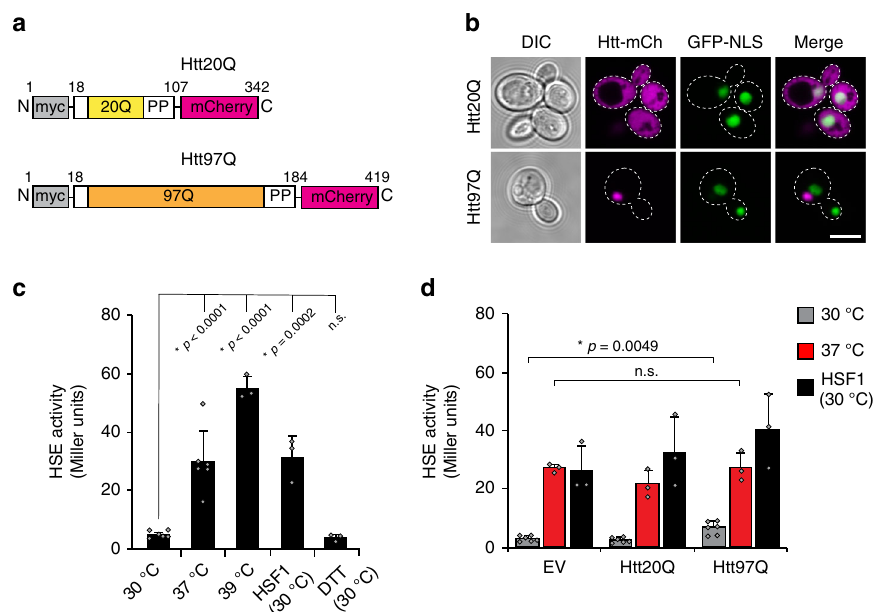
Fig. 1 Aggregation of polyQ expansion protein does not trigger a stress response in yeast. a Schematic of constructs expressing Huntingtin (Htt) exon-1 with either 20 Q (Htt20Q) or 97 Q (Htt97Q), tagged with a N-terminal Myc epitope and fused to mCherry under a galactose-inducible promoter. PP, poly- proline sequence. b Localization of Htt constructs in cells. Confocal images of cells containing Htt20Q or Htt97Q constructs and a nuclear targeted